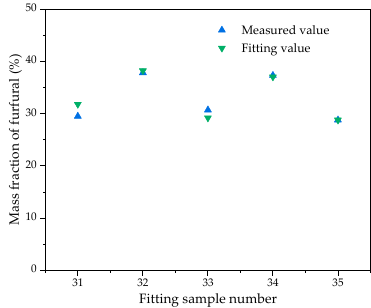
Figure 14. Comparison between the predicted value and measured value of furfural distribution ratio in oil.